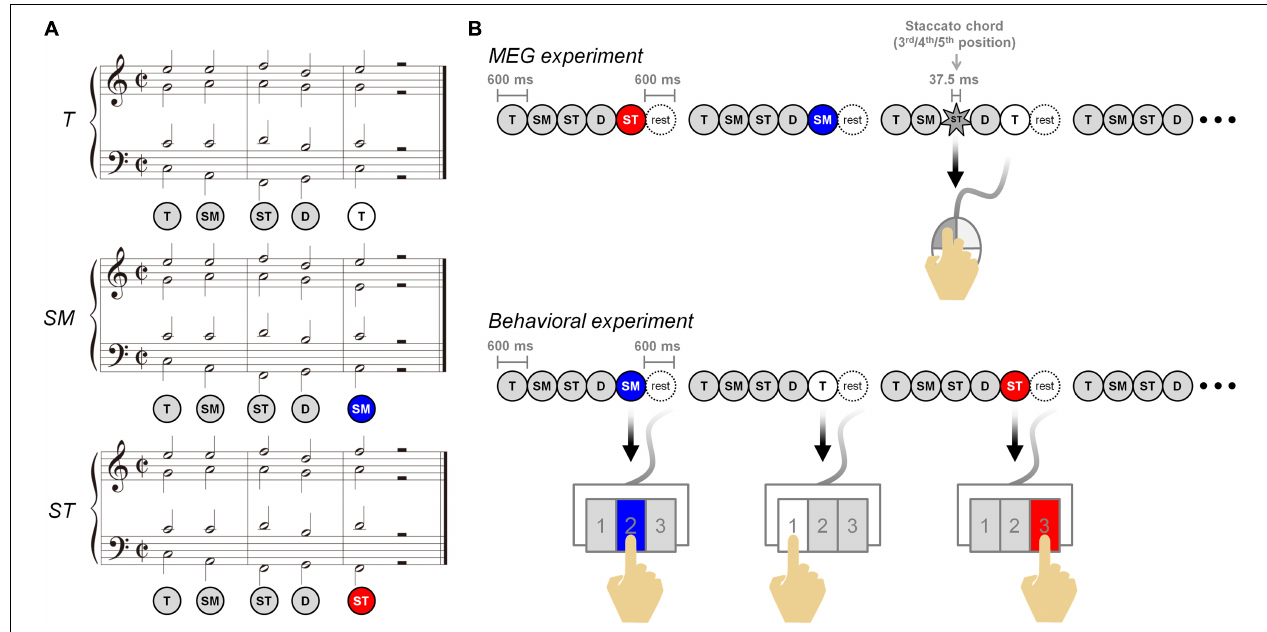
FIGURE 1 | Musical stimuli and experimental paradigm. (A) Musical stimuli are composed of three different five-chord sequences. The three conditions are T , SM , and ST , ending with dominant to tonic, dominant to submediant, and dominant to supertonic, respectively. (B) In the magnetoencephalography experiment (top), the participants listened to the three conditions carefully and were asked to detect the staccato chord among chord sequences in the three conditions, and to click a mouse (to check the level of attending the conditions). In the behavioral experiment (bottom), the participants discriminated the three conditions and responded by using the 1, 2, and 3 buttons on the